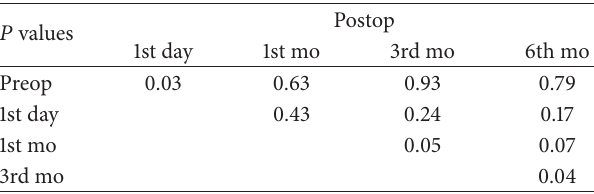
Table 3: Statistical significance in the comparison of OCT measure- ments without